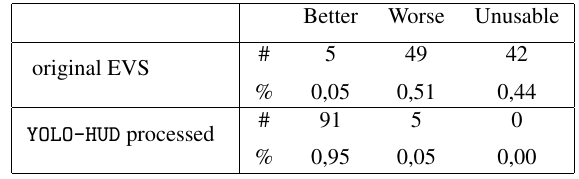
Figure 5. Examples from the dataset. Table 2. Results of volunteers perceptual evaluation.